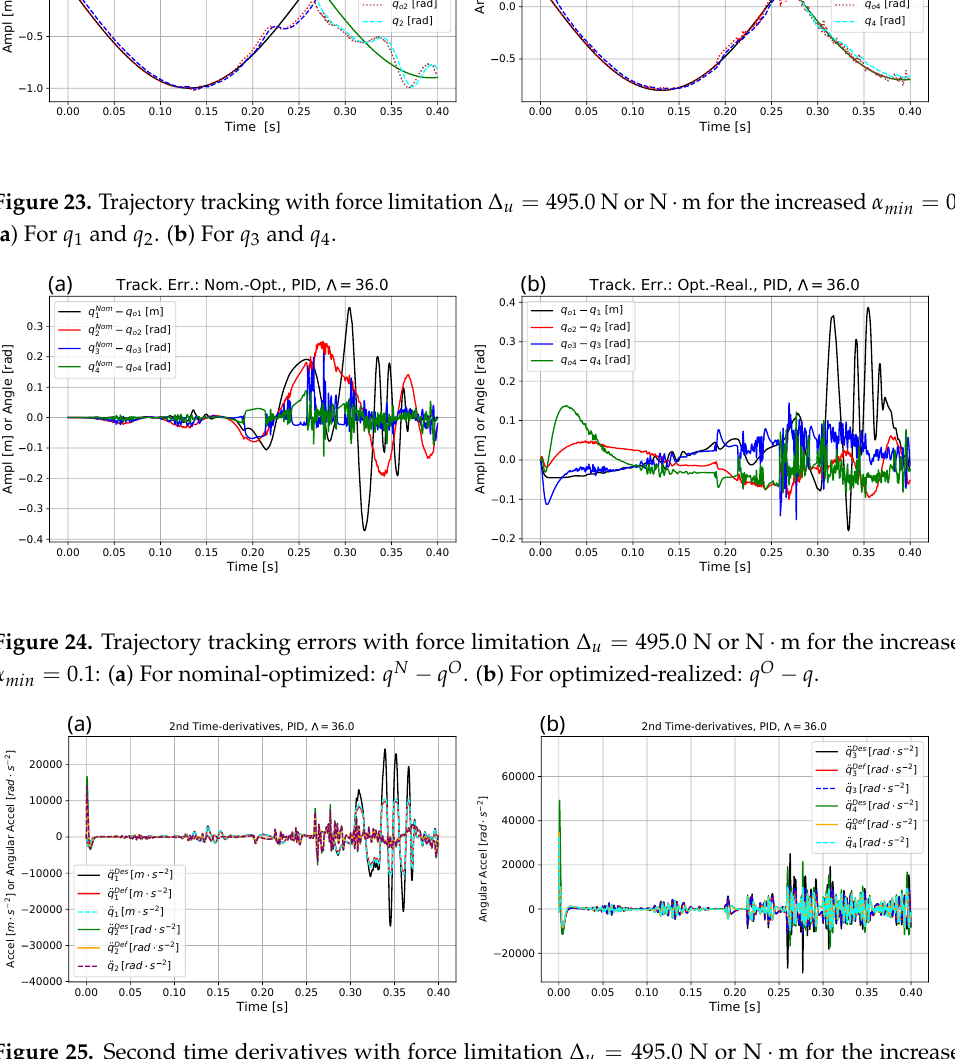
Figure 25. Second time derivatives with force limitation ∆ u = 495.0 N or N · m for the increased α min = 0.1 ( a ) for the joint coordinates q 1 ( t ) and q 2 ( t ) , ( b ) for the joint coordinates q 3 ( t ) and q 4 ( t )